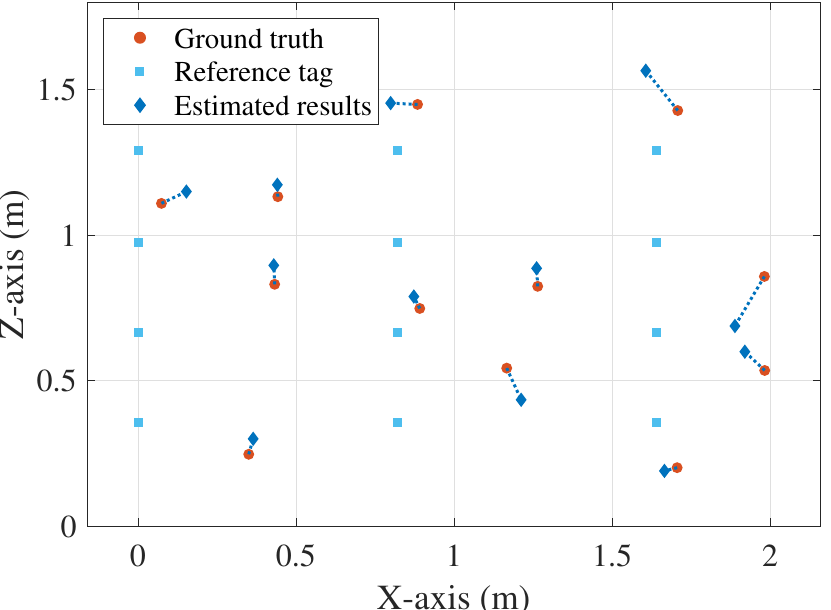
Figure 11. The figurative localization result of the experiment scenario.